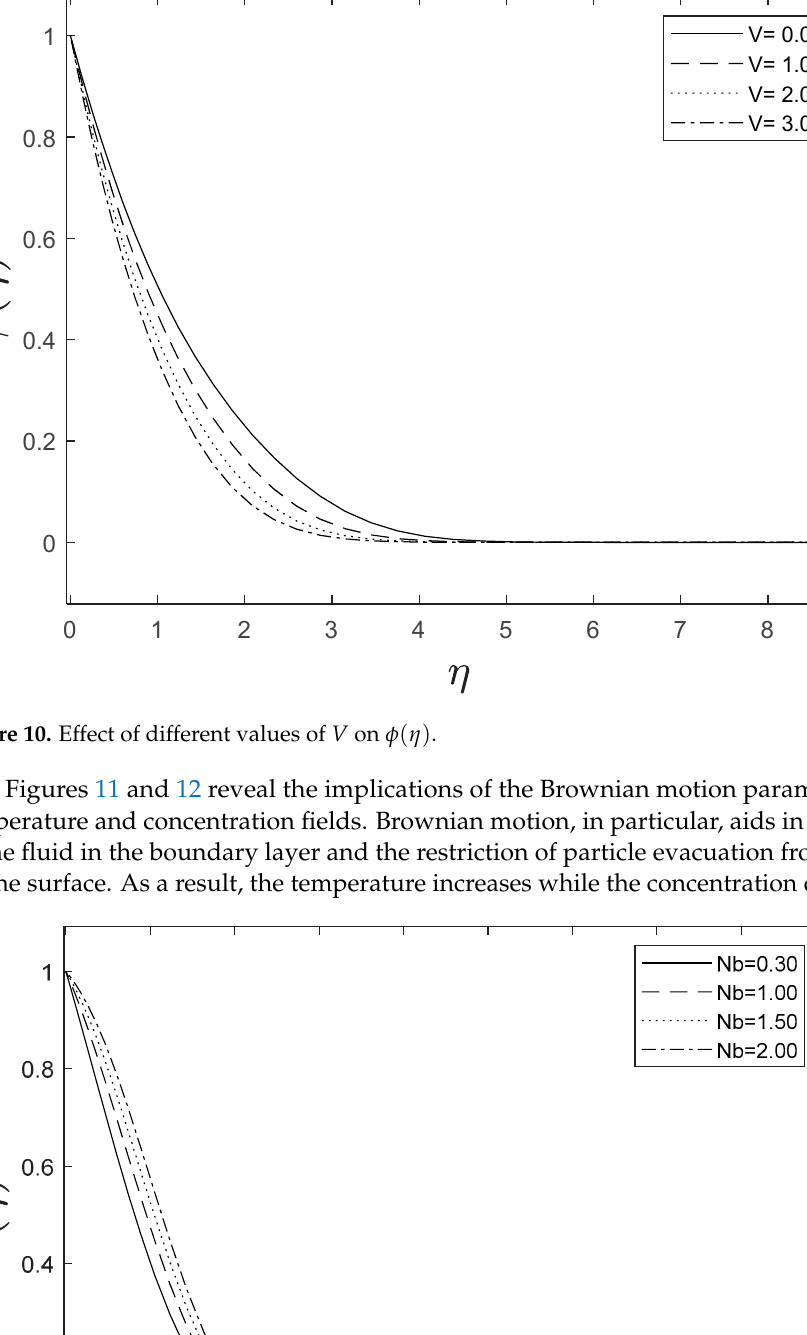
Figure 11. Effect of different values of Nb on θ ( η )